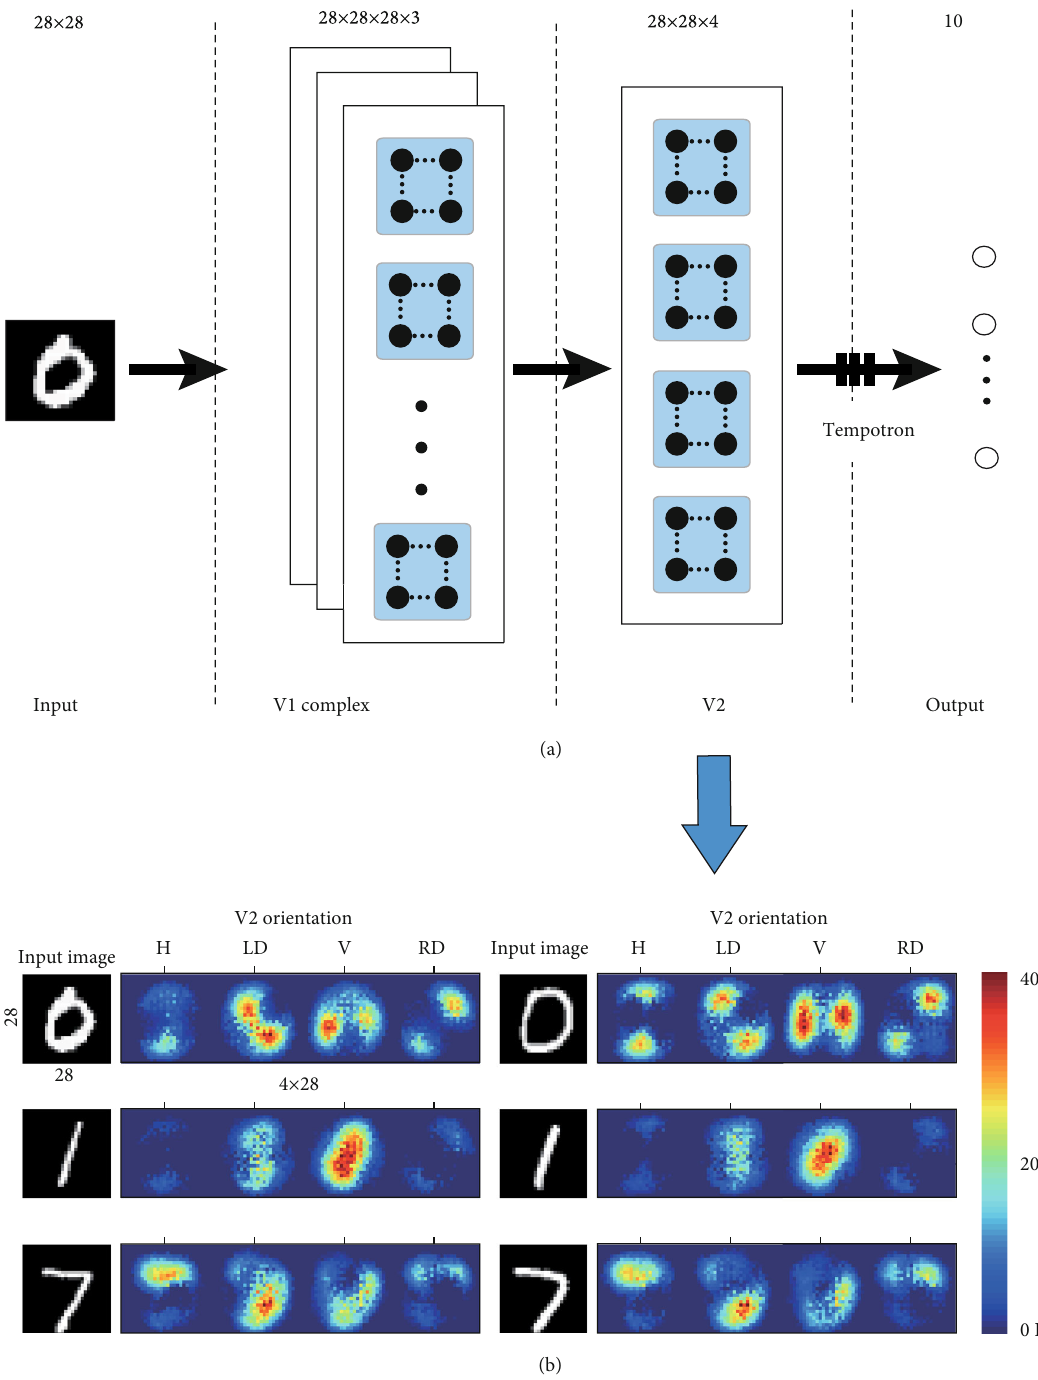
Figure 1: (a) Network architecture. The network is divided into four layers (dotted boxes). The input layer (MNIST grayscale images with 28 × 28 pixels) was fed through a feed-forward network consisting of V1 and V2, which then projected to a downstream population of decision neurons (output layer). The black dot is the Izhikevich model, and the white circle is the leaky integrate-and- fi re (LIF) model. The input is the raw pixel value of MINIST grayscale images. V1 simple and complex cell responses were constructed by using the rate- based motion energy model. Simulated spiking neurons in V2 received input only from V1 complex cells and preferentially responded to one of four spatial orientations. There are full connections from the V2 layer to the output layer, with the weights updated by the tempotron learning rule. (b) Some MNIST samples ( 28 × 28 ) and their corresponding orientation-selective responses ( 28 × 112 ). Each image is spatially expanded into four pool orientation-selective responses of the V2 layer neurons, with each pool of neurons preferentially responded to one of four spatial orientations (horizontal “ H, ” right diagonal “ RD, ” vertical “ V, ” and left diagonal “ LD ” ). Firing rates are color-coded ranging from 0 Hz (blue) to 400 Hz